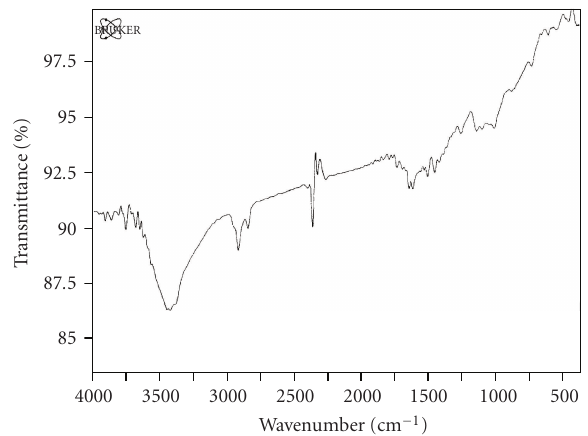
Figure 3: IR spectrum of o -aminophenol ( o -AP).